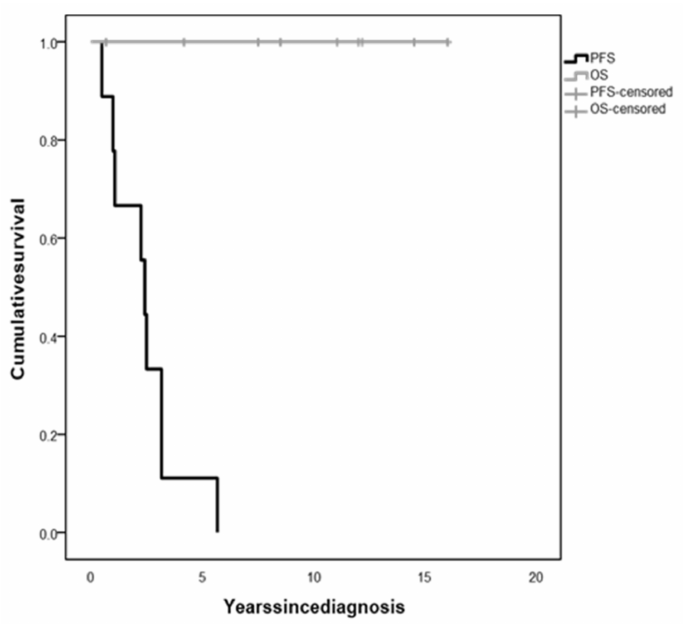
Figure 3. Overall survival (OS) and progression-free survival (PFS) of children with diencephalic syndrome due to optic pathway